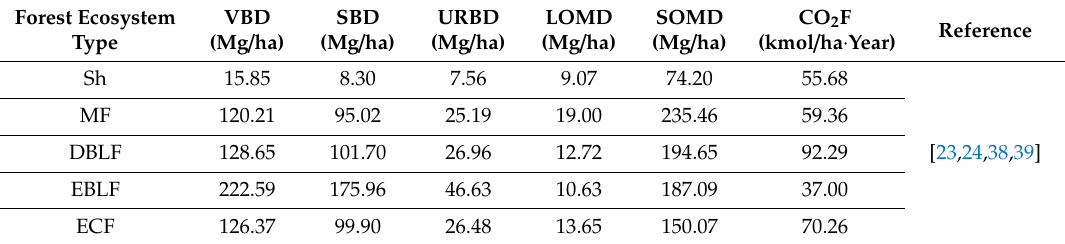
Table 1. The greenhouse gas value (GHGV) model’s localized parameters of China’s forest ecosystems. Forest